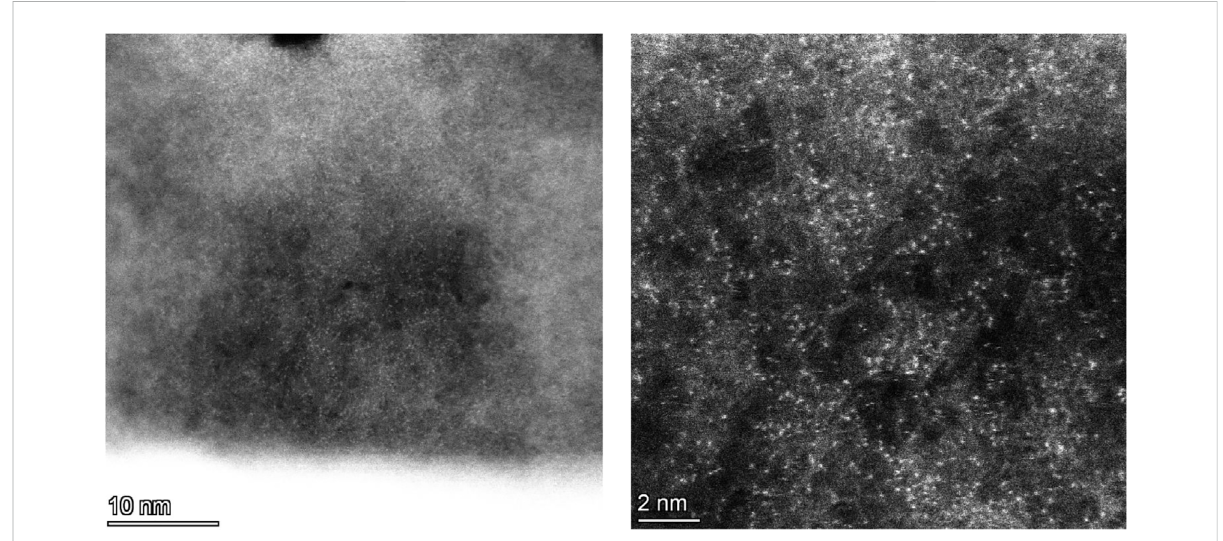
FIGURE 5 Spherical aberration-corrected TEM images of Cu-pCN-oxalate with strong single-atom